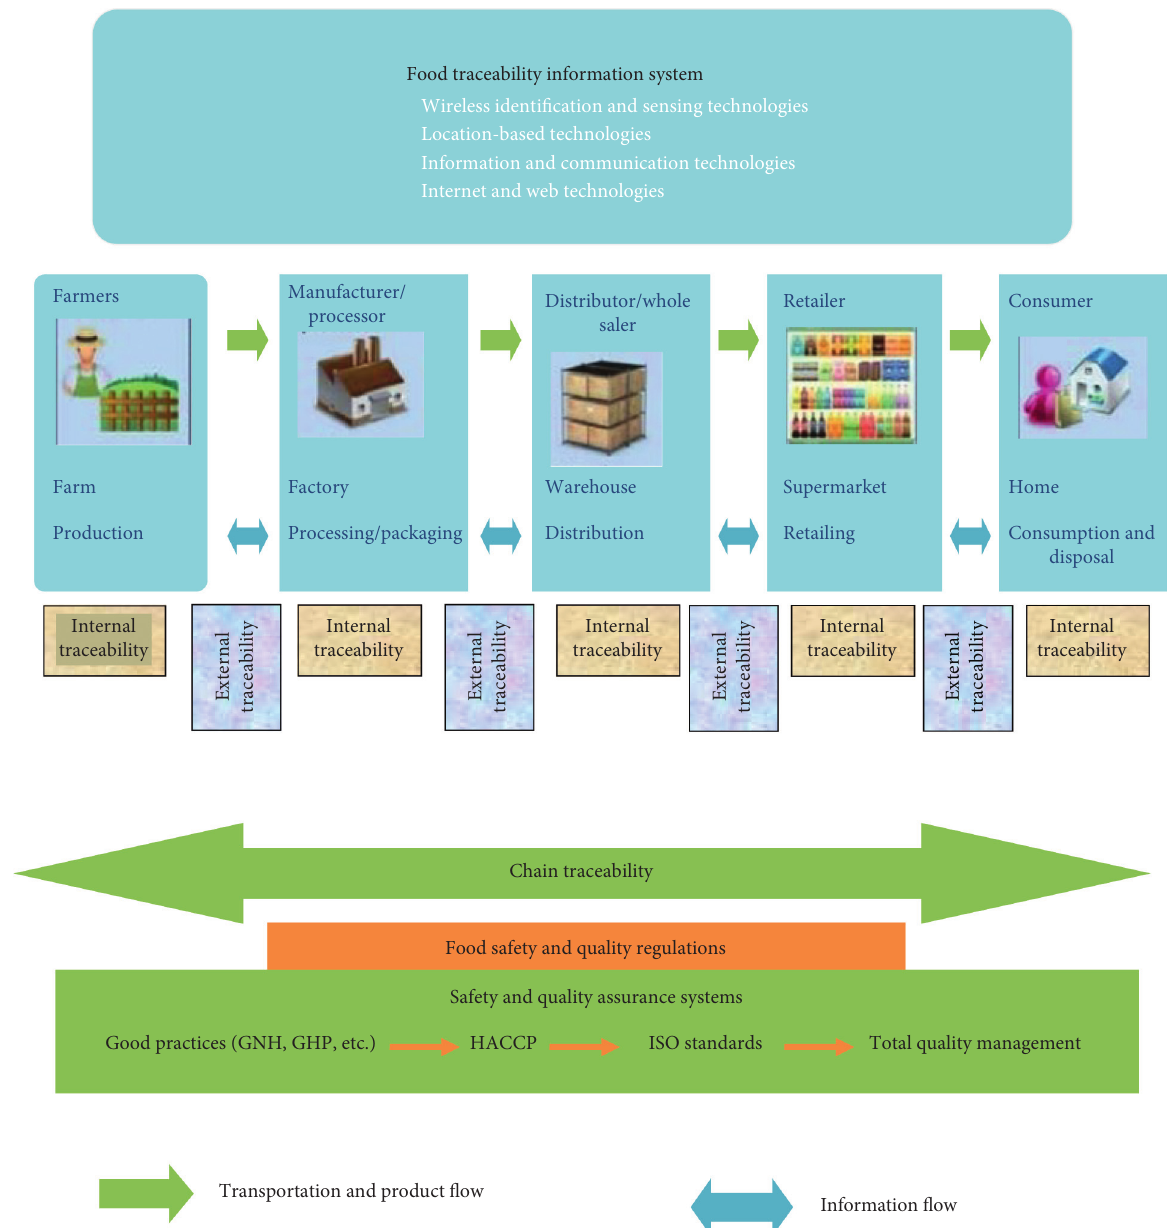
Figure 3: Traceability in a food supply chain: safety and quality perspectives